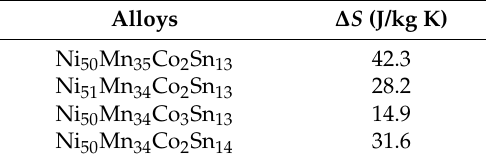
Table 2. The ∆ S values at the structural transition obtained from DSC curves for Ni-Mn-Co-Sn